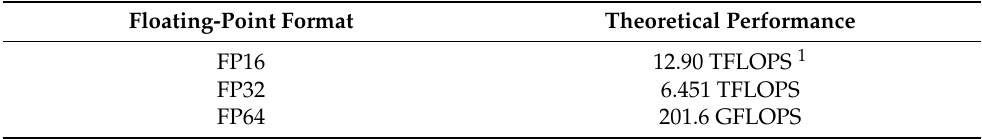
Table 1. Theoretical floating-point number performance of NVIDIA GEFORCE RTX 2060